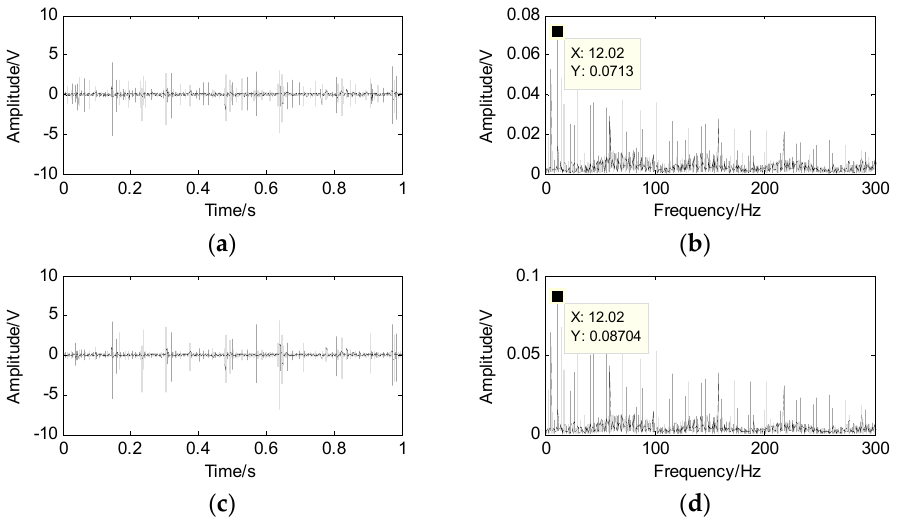
Figure 8. Mixed signal and its spectrum. ( a ) the first mixed signal x 1 ; ( b ) the spectrum of x 1 ; ( c ) the second mixed signal x 2 ; ( d ) the spectrum of x 2